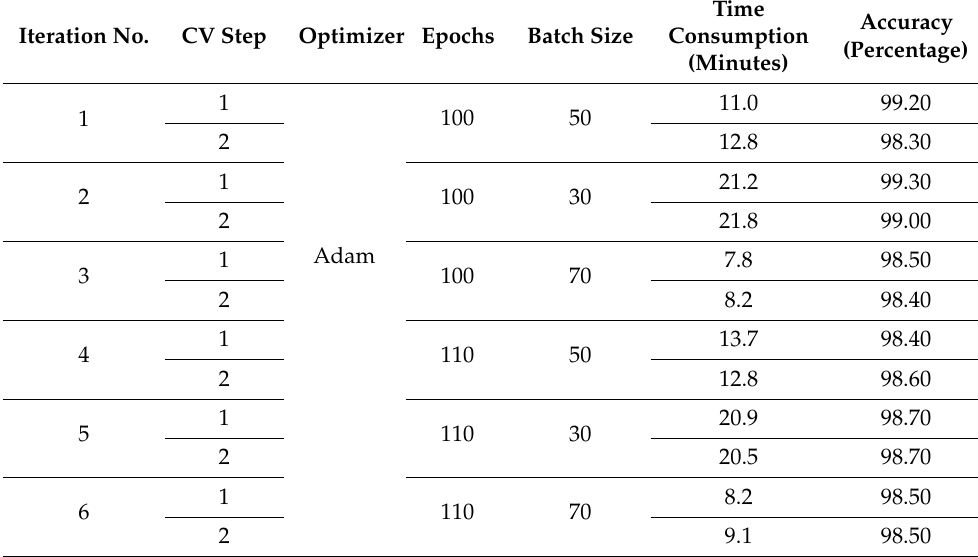
Table 6. Grid search evaluation